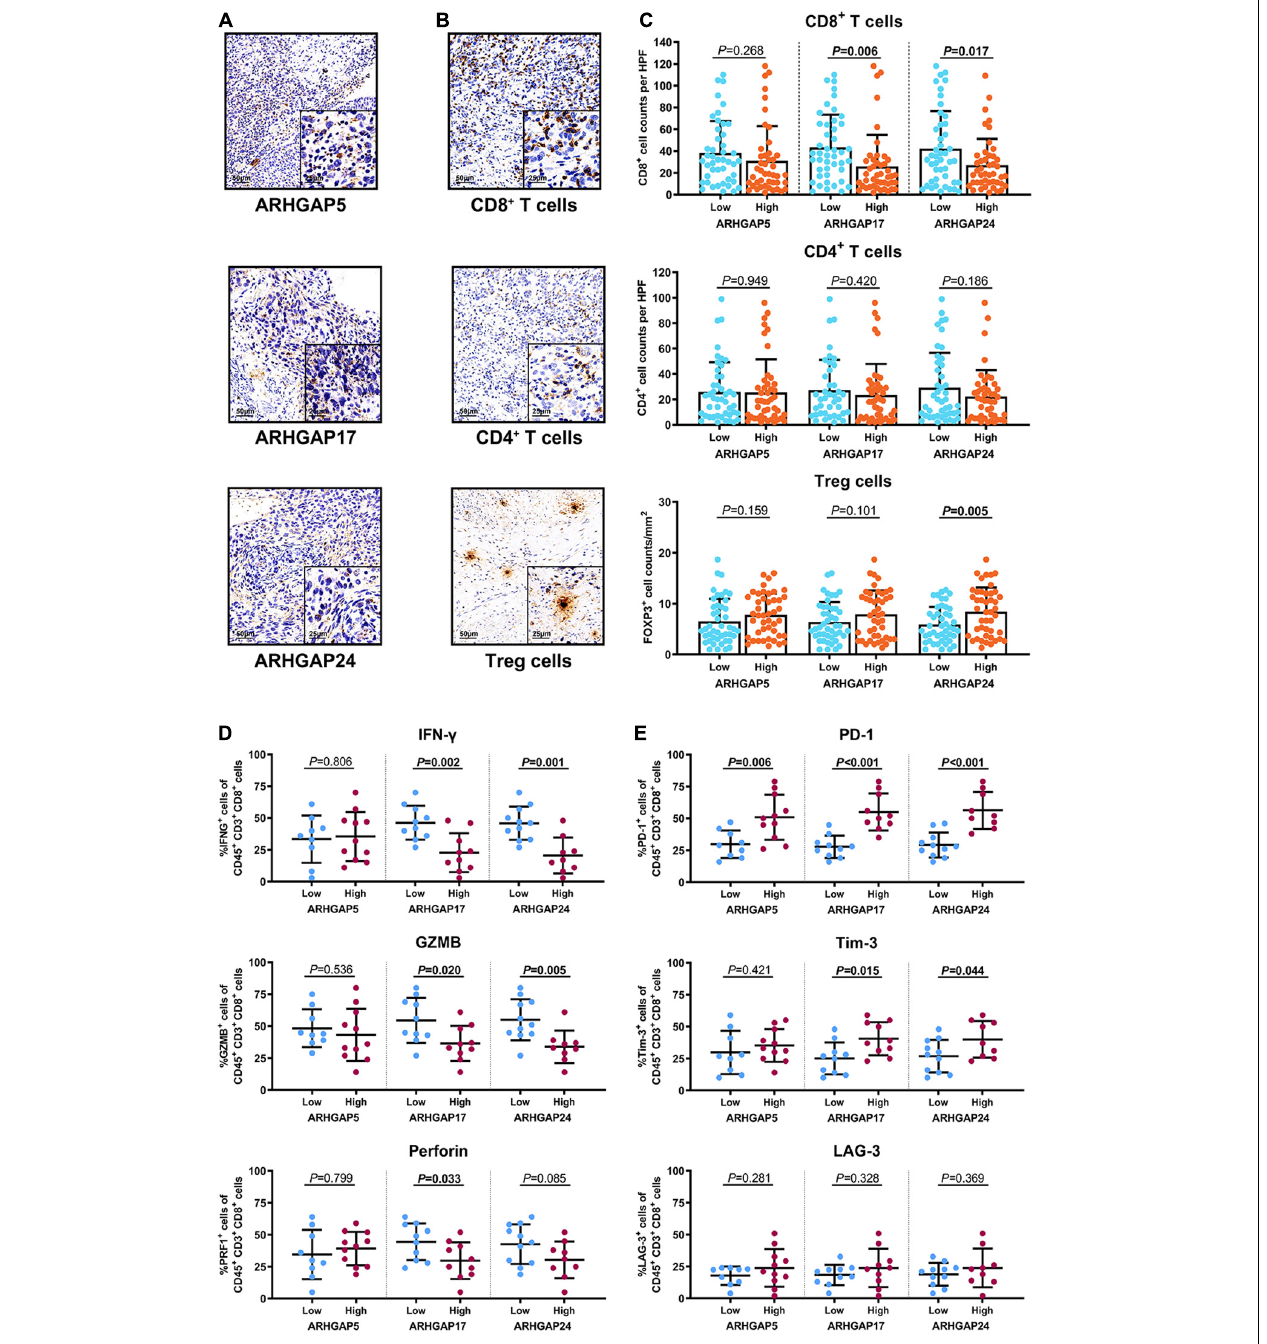
FIGURE 8 | Immunosuppressive tumor microenvironment was associated with ARHGAP family expression. (A,B) Representative immunohistochemistry staining of the ARHGAP family [ (A) ; ARHGAP5, ARHGAP17, and ARHGAP24] and immune cells [ (B) ; CD8 + T cells, CD4 + T cells, and Treg cells]. (C) Comparison of CD8 + T cell, CD4 + T cell, and Treg cell infiltration in bladder cancer according to ARHGAP5, ARHGAP17, and ARHGAP24 high/low groups. (D,E) Comparison of effector molecules [ (D) ; IFN- γ , GZMB, and perforin] and immune checkpoint [ (E) ; PD-1, Tim-3, and LAG-3] in bladder cancer according to ARHGAP5, ARHGAP17, and ARHGAP24 high/low